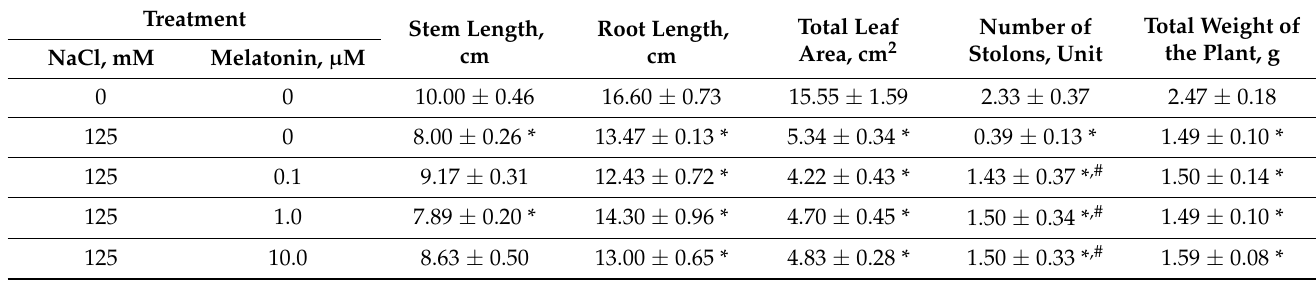
Table 1. Influence of melatonin and chloride salinity on the growth rates of Solanum tuberosum plants. Treatment Stem